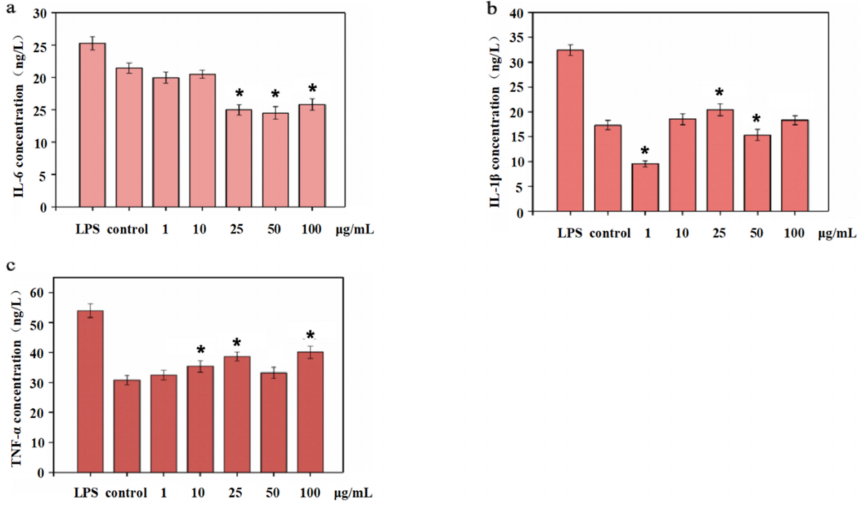
Figure 7. Level of cytokines in CD8 + T cells treated with varying concentrations of NTCII after LPS stimulation (( a ) IL-6, ( b ) IL-1 β , ( c ) TNF- α ). (Shapiro-Wilk value >0.05, using one-way ANOVA and Dunntte for post hoc tests.) An asterisk indicates that there is a significant difference compared with the control group (* p <